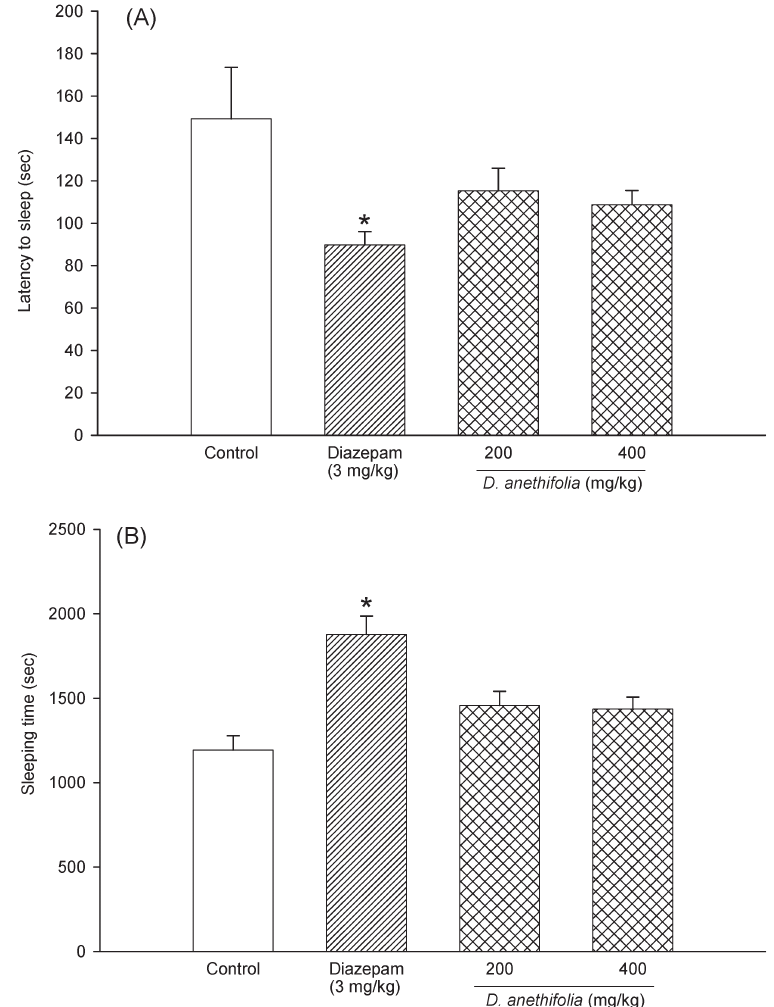
Figure 4 - Effects of diazepam and D. anethifolia extract on (A) the latency to loss of righting reflex and (B) total sleep time. The interval between the administration of ketamin until the loss of the righting reflex was recorded as onset of sleep. The time from loss of righting reflex to regaining of the righting reflex was recorded as duration of sleep. Results represent mean ( ¡ S.E.M.) from six mice. *P , 0.01 compared with